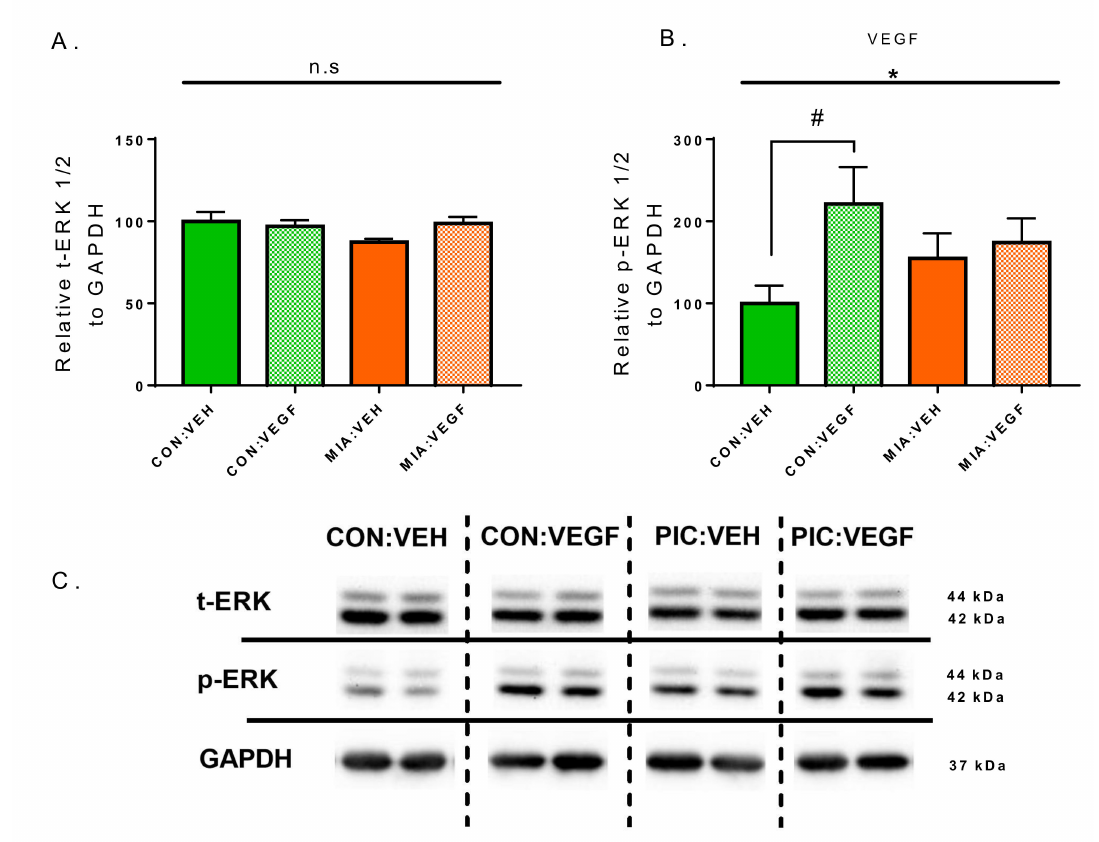
Figure 3. Quantification of total ERK (t-ERK) and phospho-ERK (p-ERK) levels by Western blot. ( A ) Relative total ERK to GAPDH. ( B ) Relative p-ERK to GAPDH. ( C ) Representative Western blot images. Data are normalized to the CON:VEH group for comparison and presented as mean ± SEM. Statistical significances resulting from 2WAY-ANOVA are marked with * ( p < 0.05). Statistical significances resulting from Fisher’s LSD test are marked with # ( p < 0.05); n = 9–10 /